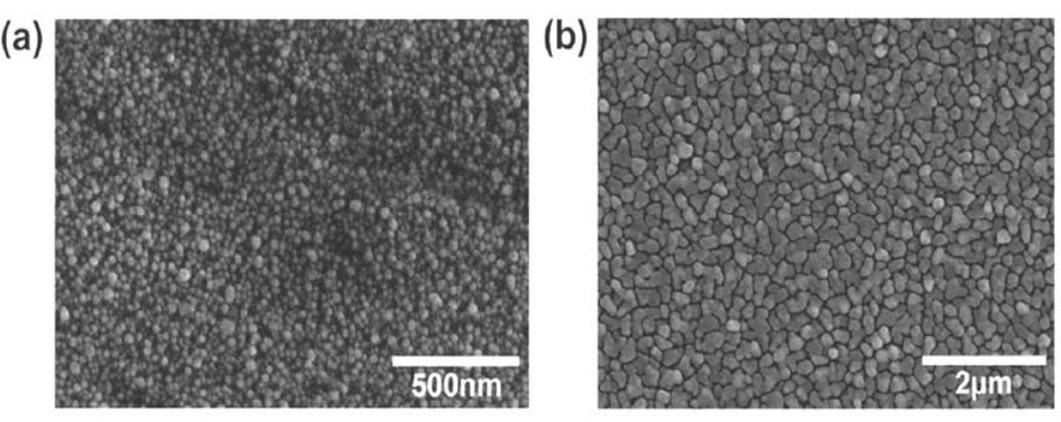
Figure 3. Scanning electron micrographs of copper films on fiber with an average thickness of ( a ) 5 nm and ( b ) 40 nm.